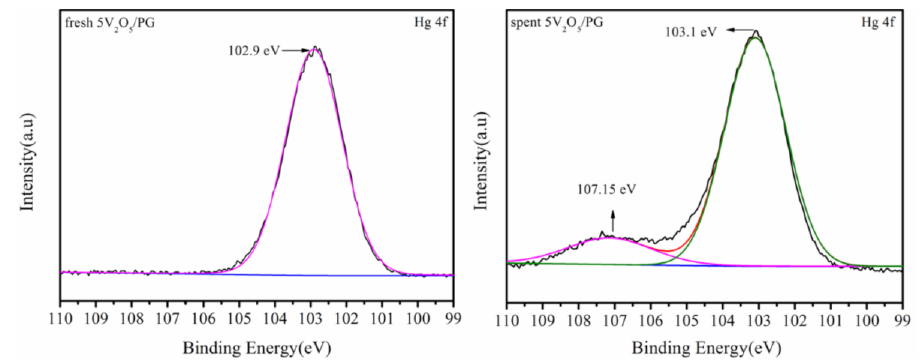
Figure 6. XPS of Hg 4f for fresh and spent V 2 O 5 /PG